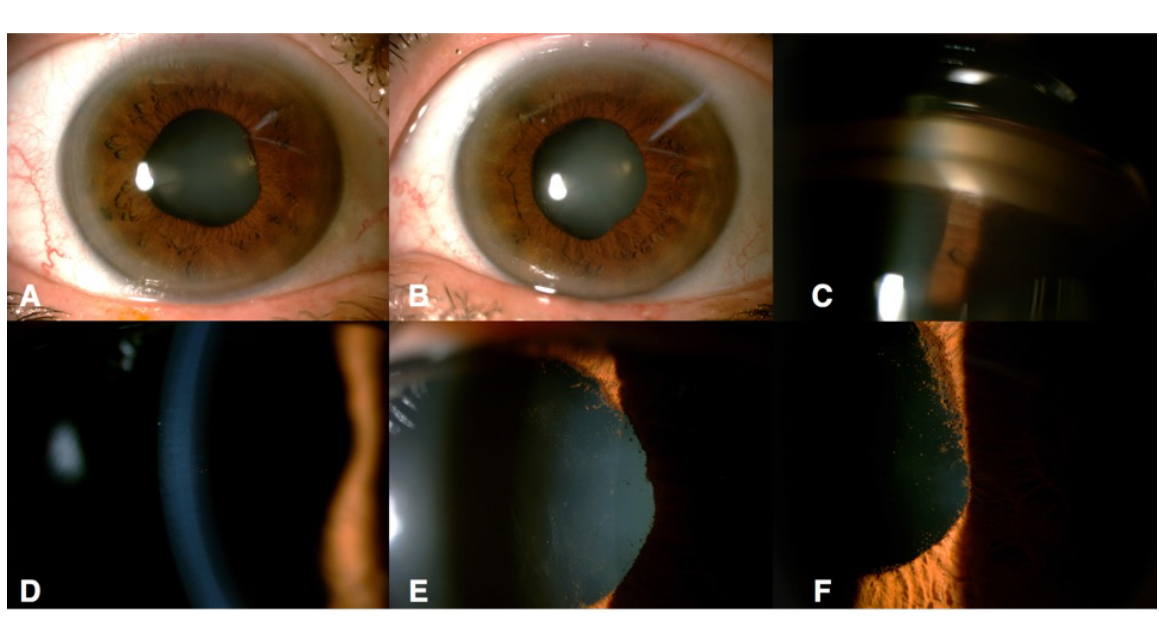
Figure 1: Clinical photography of both